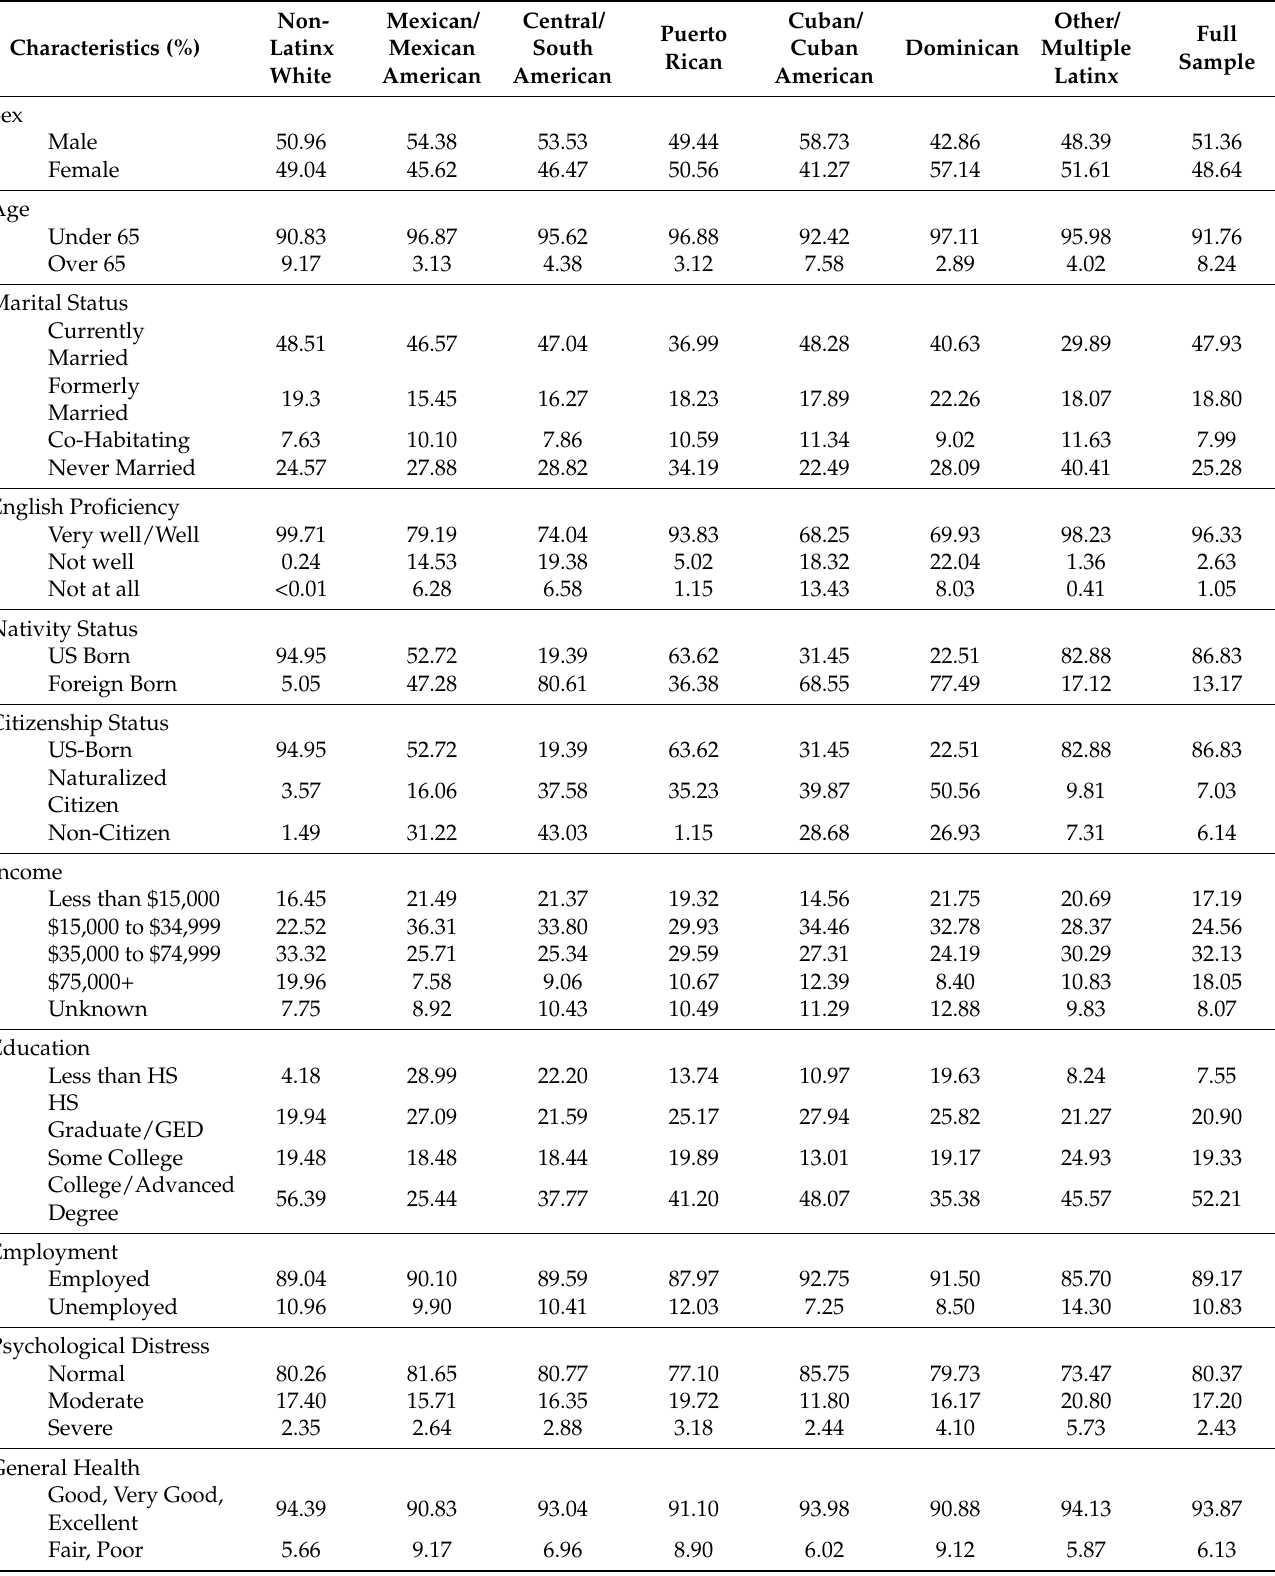
Table 1. Weighted Sample Characteristics in Percentages (N =